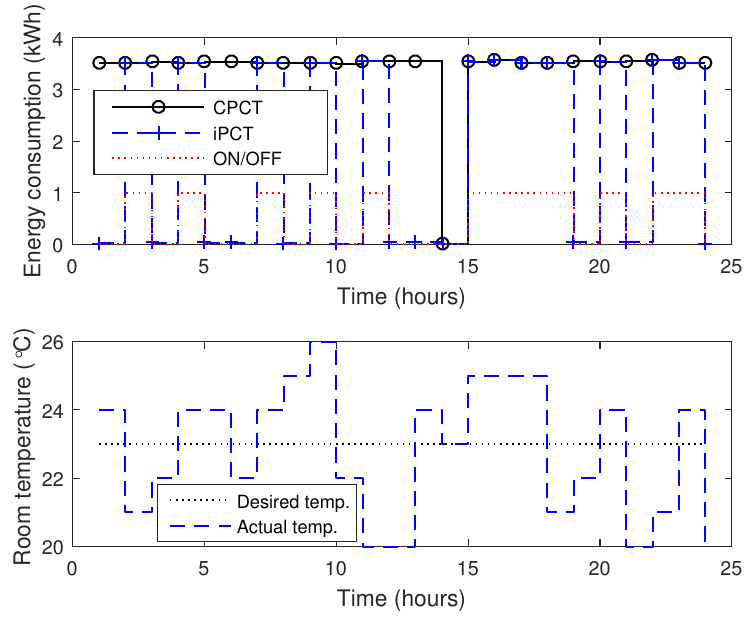
Figure 8. Energy consumption of HVAC w.r.t variation in room temperature with number of